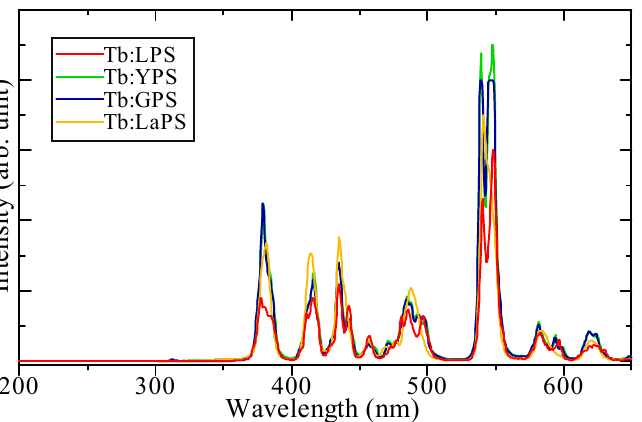
Figure 6. X-ray induced scintillation spectra of Tb-doped LPS, YPS, GPS, and LaPS samples.